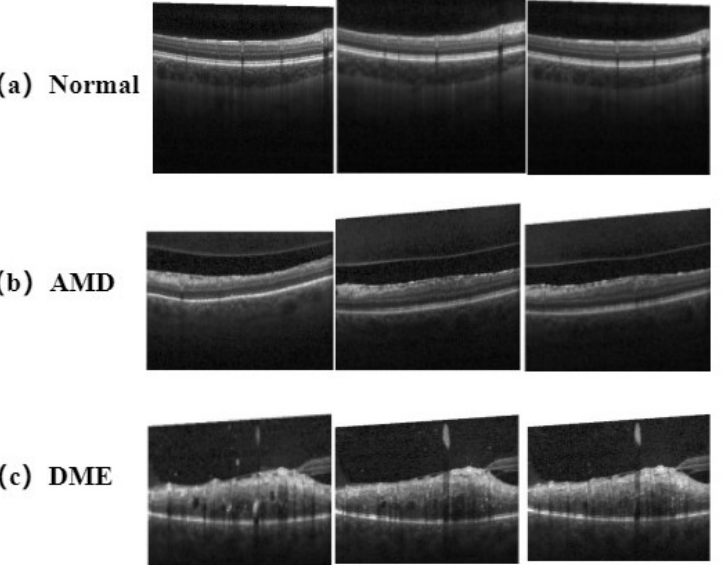
Figure 7. Sample category visualization for the Srinivasan 2014 dataset. ( a ) Normal: The normal retina presents regular depressions; ( b ) Age-related Macular Degeneration (AMD): Due to hemorrhage and fluid exudation caused by macular degeneration, a new layer of membrane forms on the retina, and edema forms at the lesion site. New layers and irregular protrusions appear; ( c ) Diabetic Macular Degeneration (DME): Due to the accumulation of retinal fluid, retinal thickness increases and reflectivity decreases, resulting in an increase in central thickness and a decrease in intensity of the image.